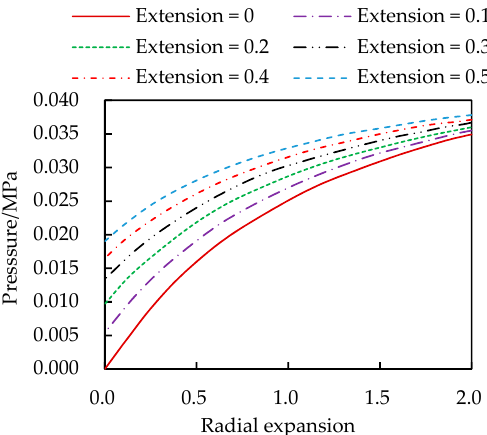
Figure 4. Internal pressure vs. radial expansion and axial extension. Materials 2020 , 13 , x FOR PEER REVIEW